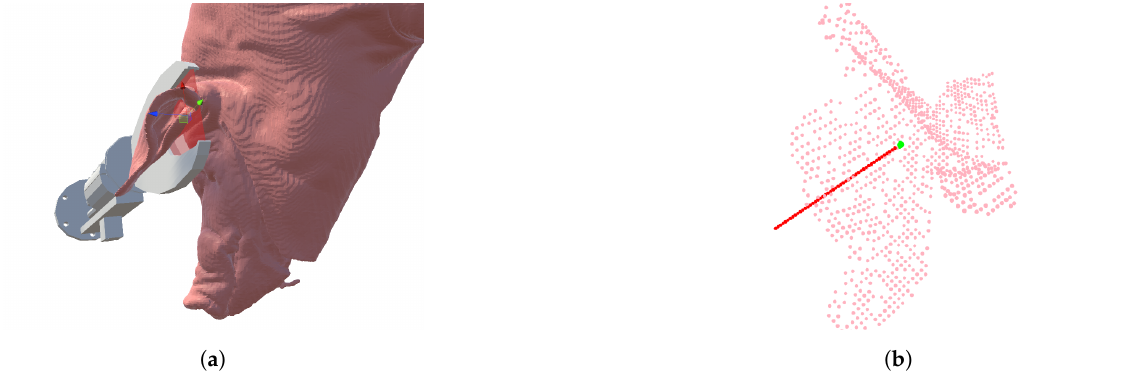
Figure 1. ( a ) Correct tool pose illustrated using 3D models of the tool and pig. ( b ) A point cloud of the ear region with our representation of a 5-DoF cutting plane consisting of P 0 (green) and (cid:126) nz (red).